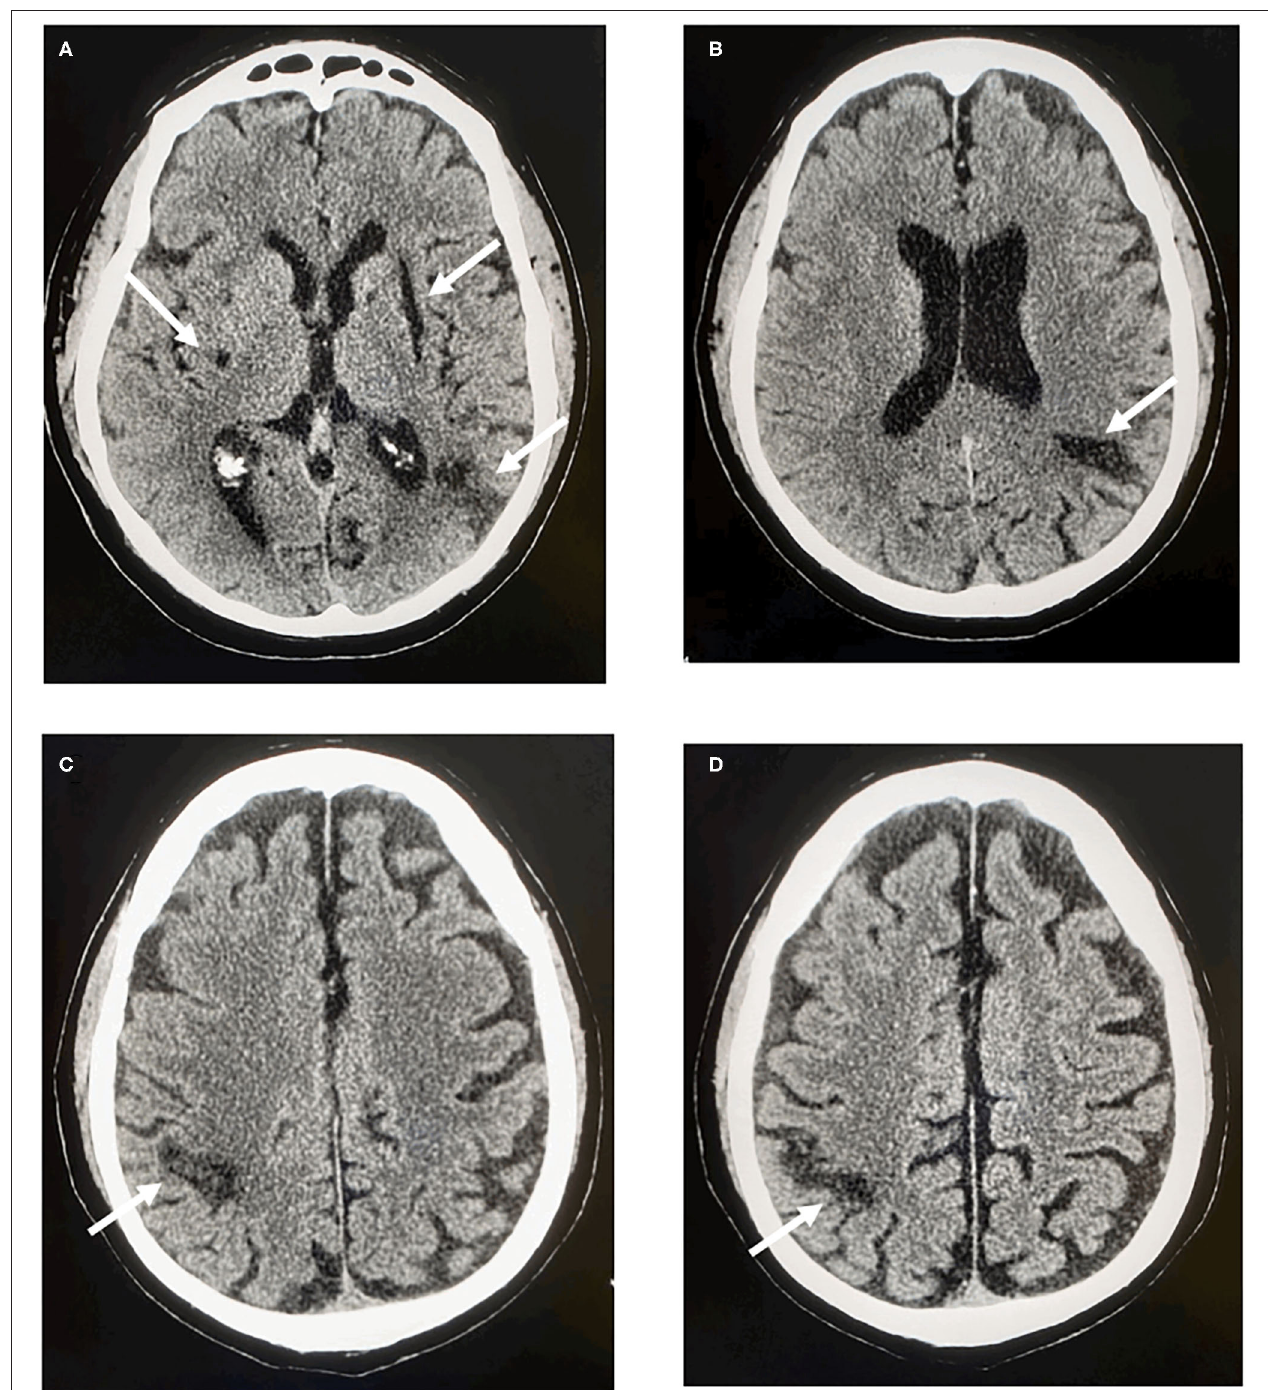
FIGURE 1 | CT scan of the brain. (A) Left side: cortico-subcortical temporo-parieto-insular hypodensity. Right side: subcortical lenticular hypodensity. (B) Left side: cortico-subcortical parietal hypodensity. (C,D) Right side: cortico-subcortical parietal hypodensity.